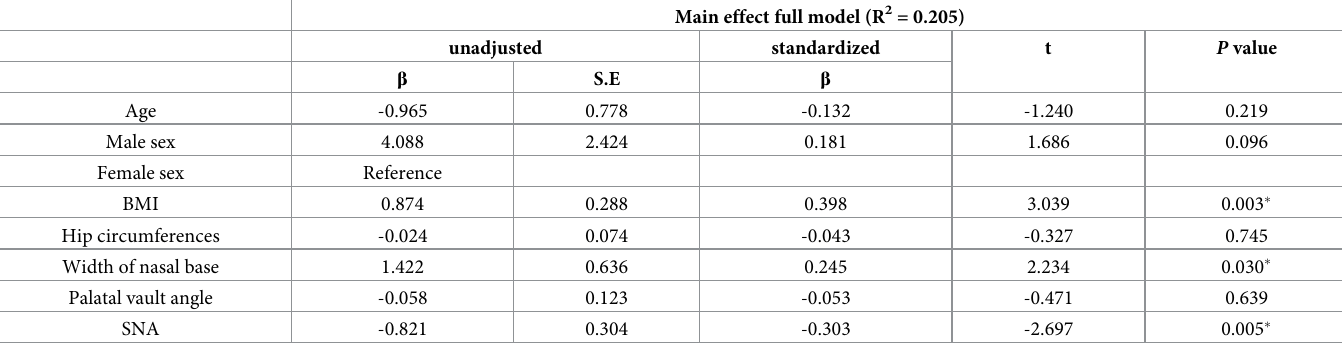
Table 3. Clinical and radiographic parameters as predictors of the AHI in the multivariate